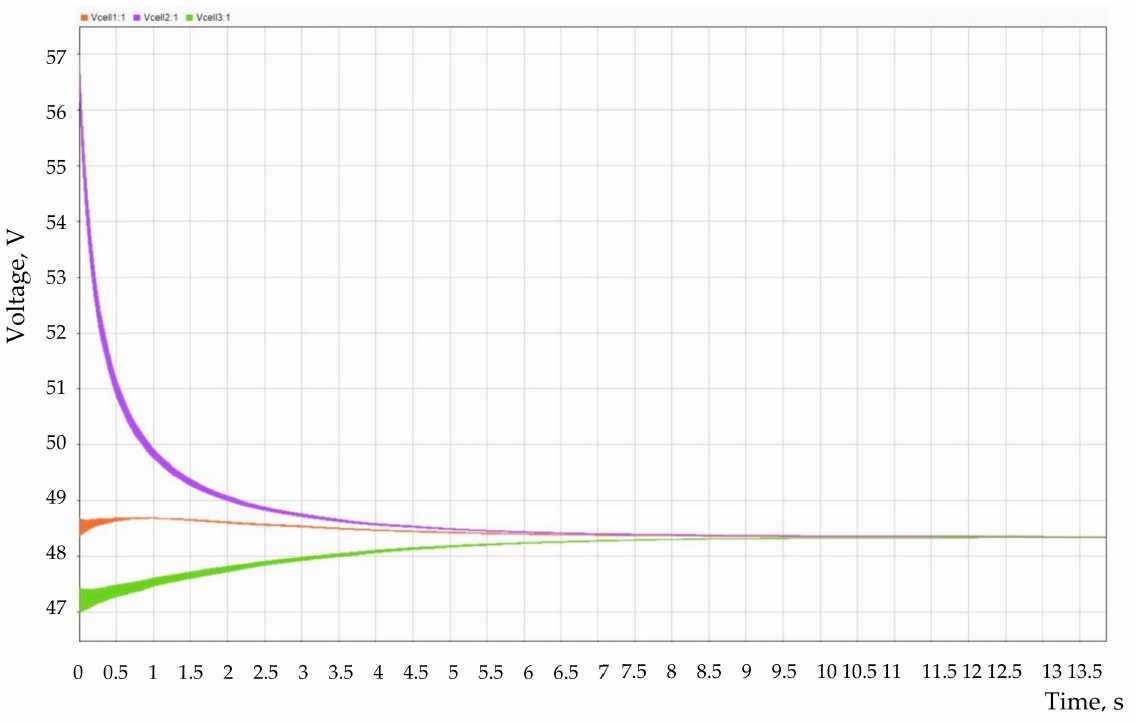
Figure 11. Changing the stack voltage when they are connected in parallel using a group of DC/AC